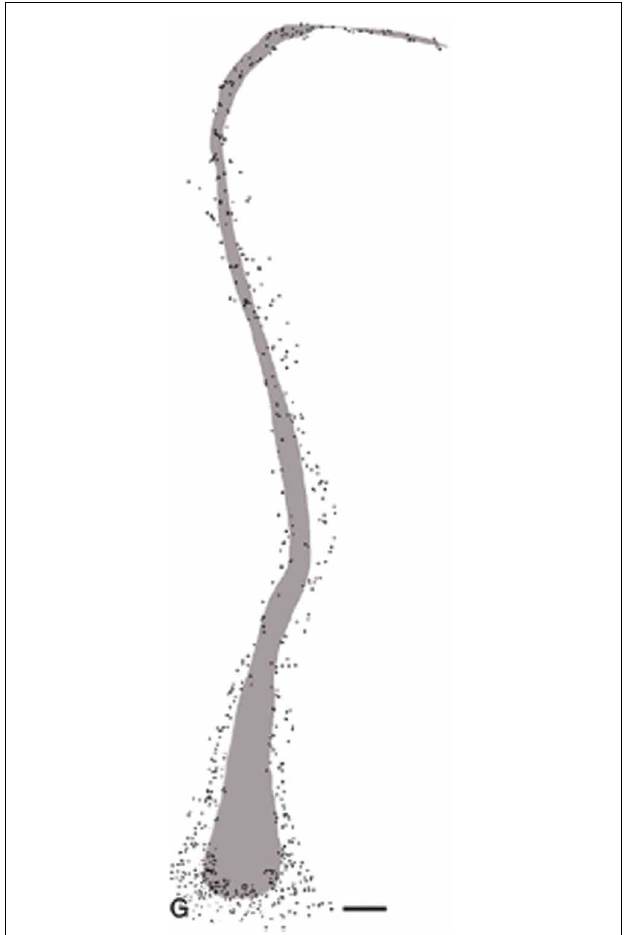
FIGURE 2 | Shaded area represents the calustrum as defined by parvalbumin immunoraectivity. The surrounding and embedded dots are immunoreactive deep layer VI cells of the insula cortex. Permission to reprint from Oxford University Press, (Mathur et al., 2009), this figure is not included under Frontiers’ CC-BY license